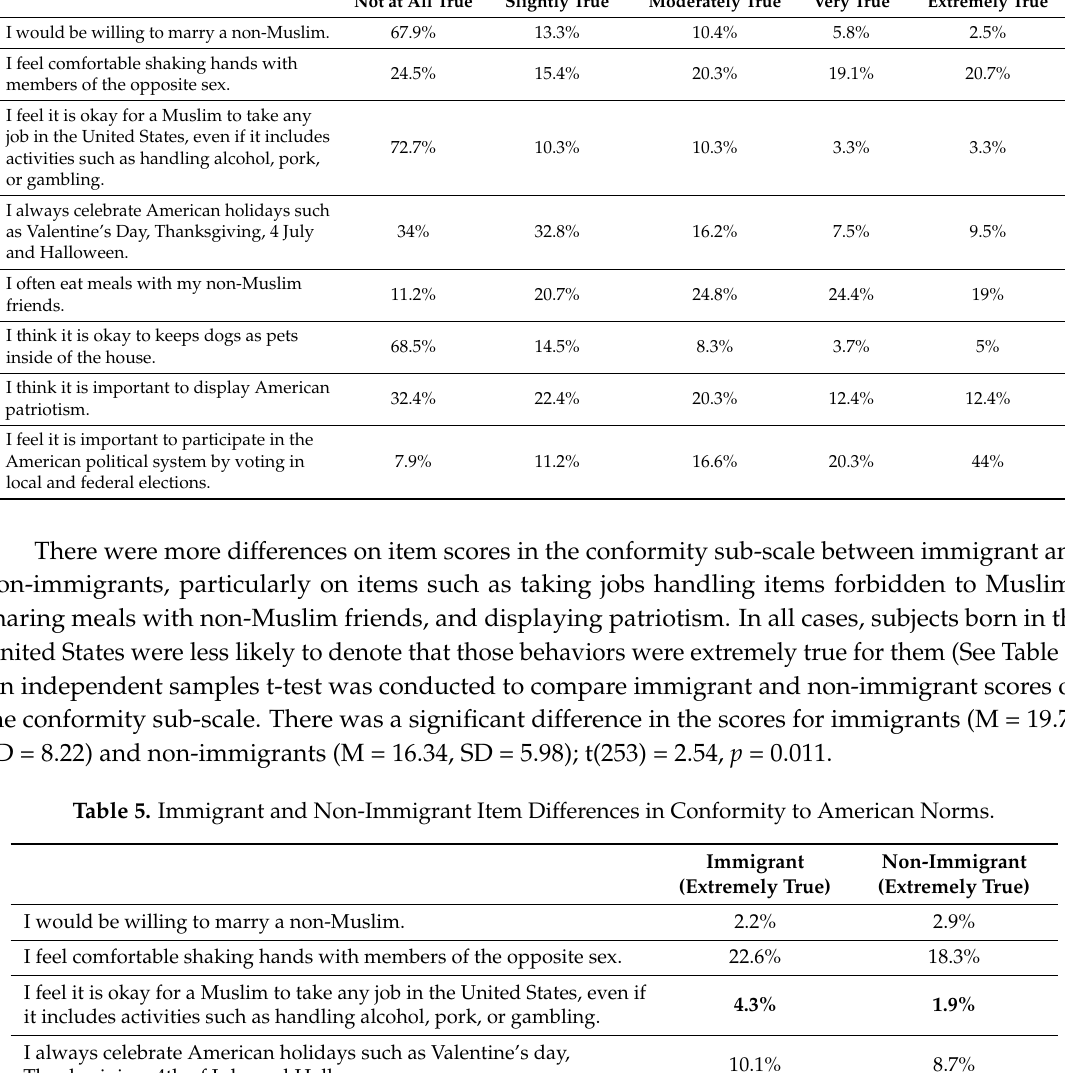
Immigrant Non-Immigrant (Extremely True) (Extremely